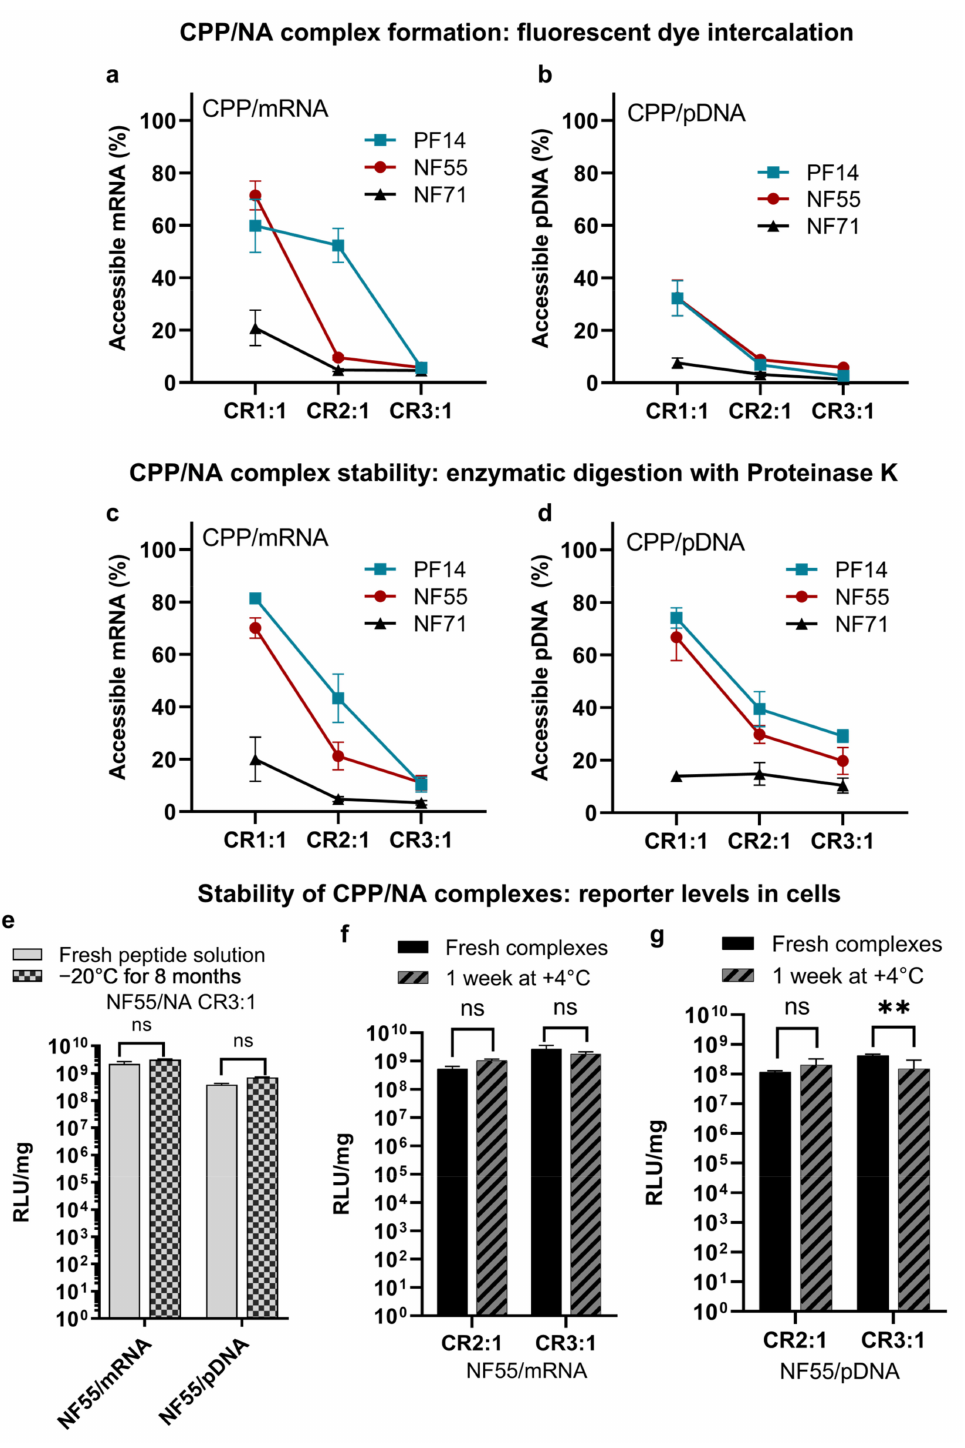
Figure 2. CPPs are able to condense and protect both mRNA and pDNA. Complex formation between CPP and ( a ) mRNA or ( b ) pDNA assessed by accessibility of nucleic acid to fluorescent nucleic acid binding dye after incubation with CPPs. CPP/NA complexes formed at charge ratios (CR) 1:1, 2:1, and 3:1 with CPPs in excess. Free nucleic acid at the same concentration was used as the control